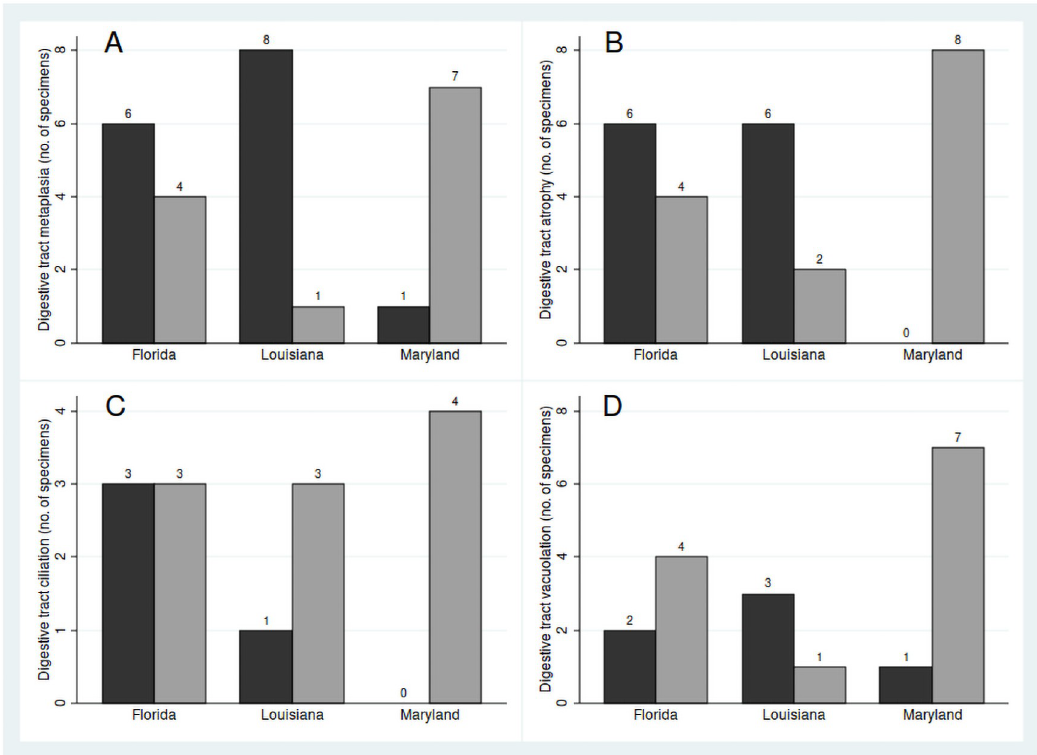
Fig 5. Proportions of specimens displaying digestive tract metaplasia. A—Occurrence of any type of digestive metaplasia (black) versus healthy individuals (grey). B—Atrophy of tract diverticula (black) versus normal diverticula (grey). C—Absence of digestive tract cilia (black), versus ciliated tracts (grey). D—Extensive cellular vacuolation (black), versus non-vacuolated cells (grey). Locations are Barataria Bay (Louisiana), Apalachicola (Florida) and Chesapeake Bay (Maryland). Numbers above bars indicate the number of